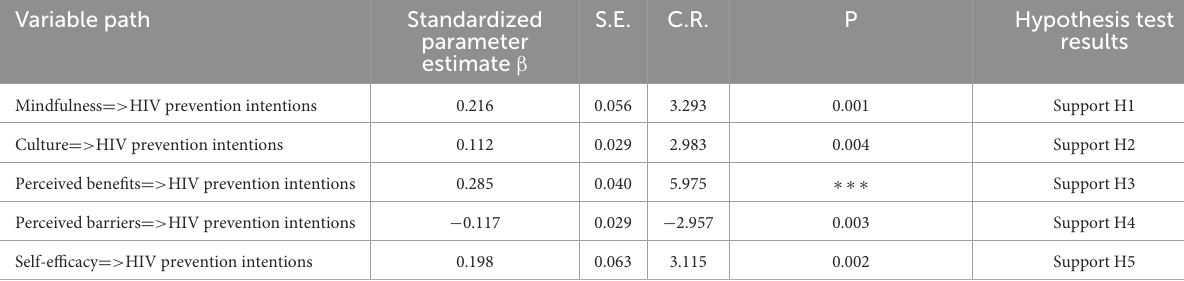
TABLE 4 Hypothesis